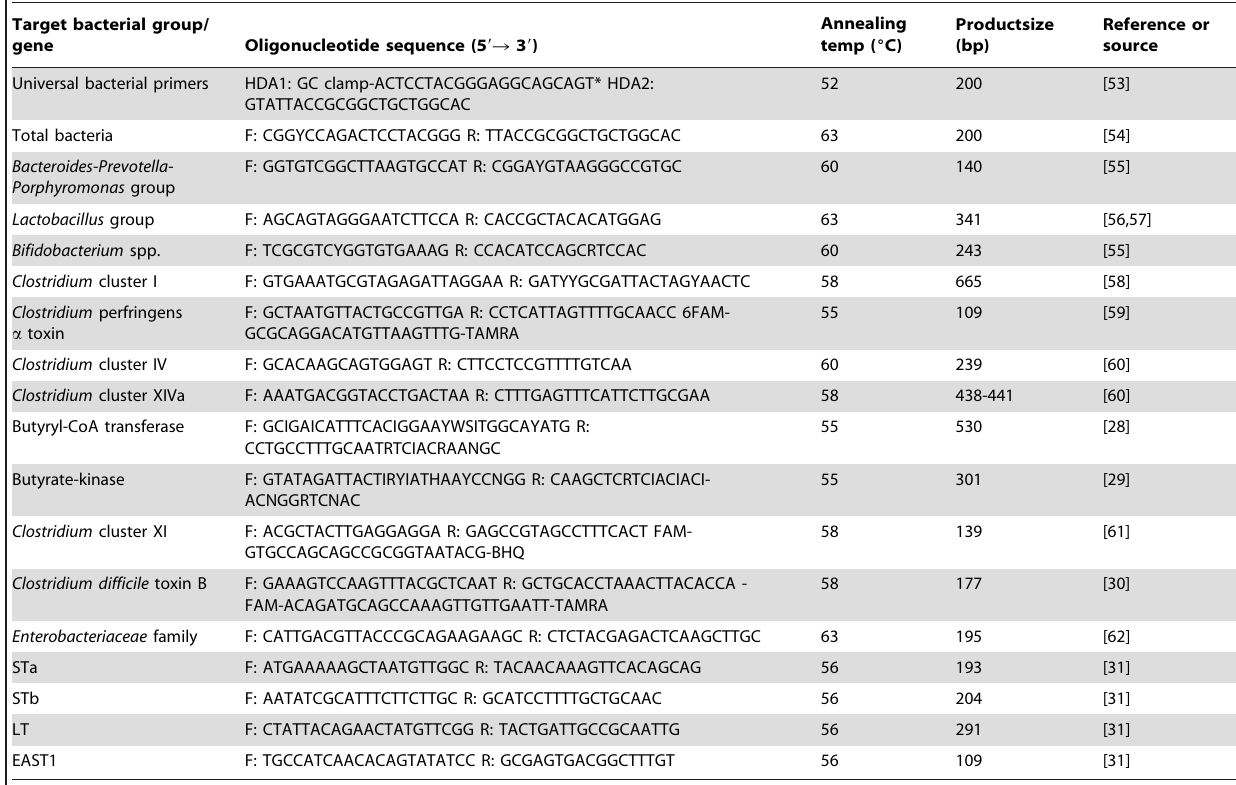
Table 1. Primers used in the study.